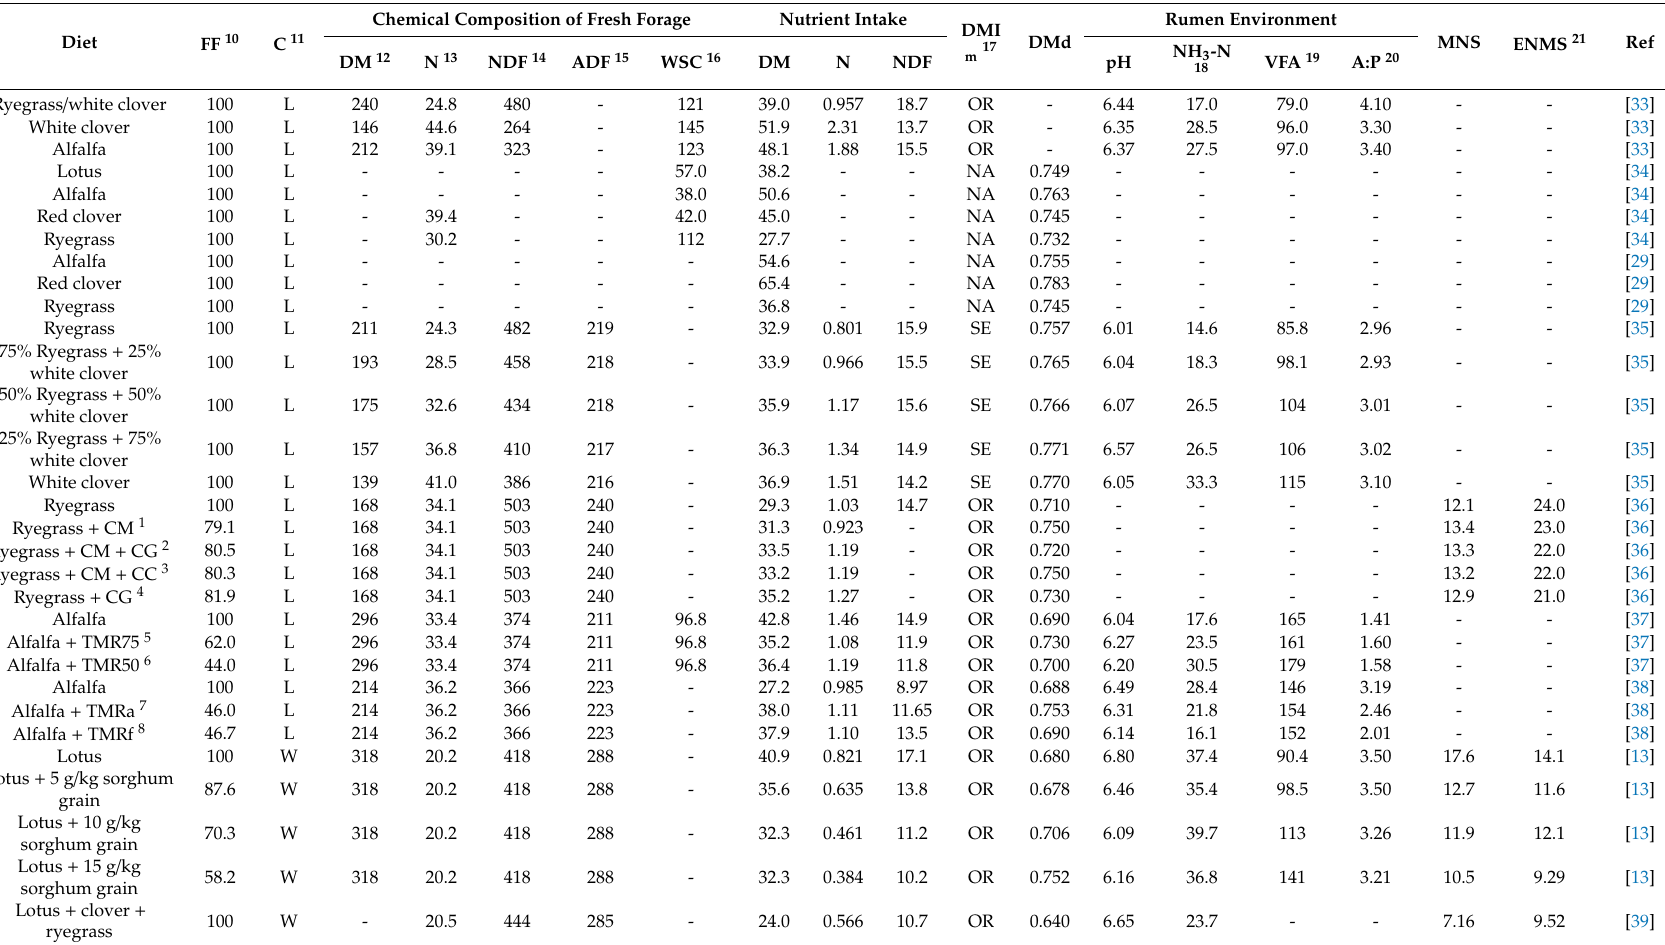
Table 1. Chemical composition of pasture (g / kg), nutrient intake (g / kg body weight), coe ffi cient of digestibility of dry matter (DMd), rumen environment, microbial nitrogen synthesis (MNS, g / d), and e ffi ciency of microbial nitrogen synthesis (ENMS) in lambs fed fresh forage (FF) or FF plus feedstu ff s (concentrate or total mixed ration,